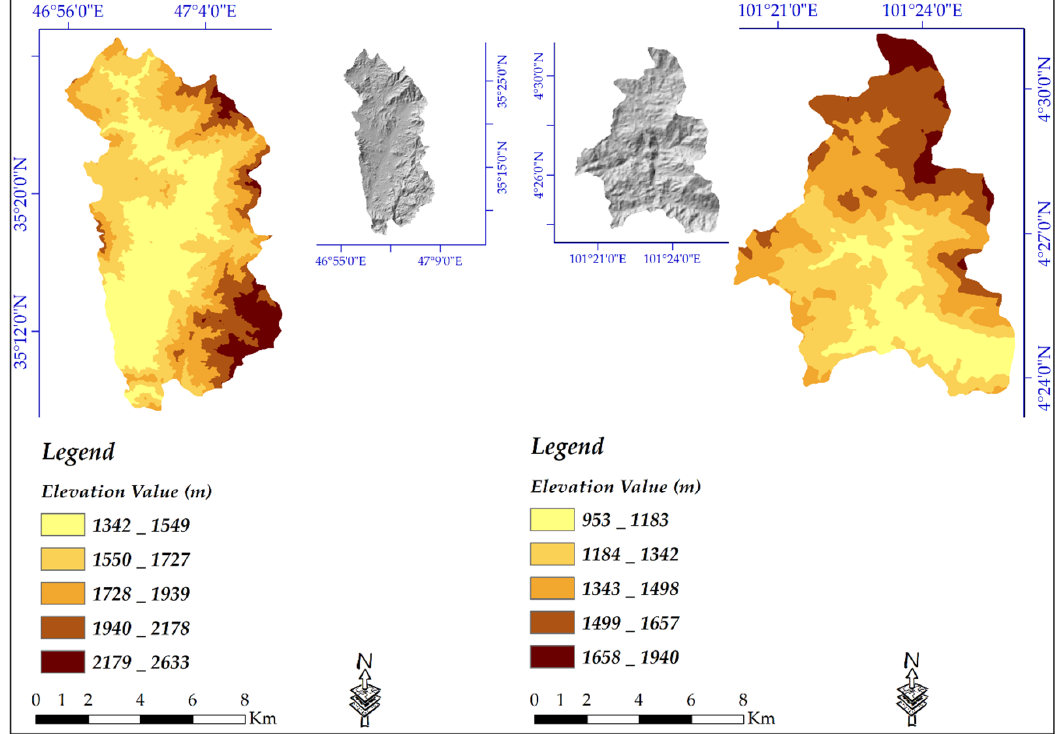
Figure 4. Extracted DEM from Sentinel_1 Satellite Data.4.2. Evaluation and Comparison of the Created DEM.